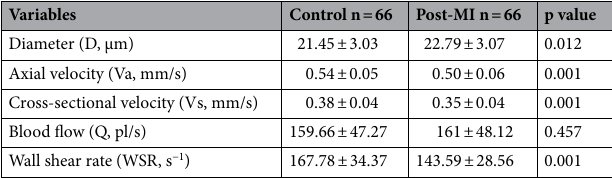
Table 2. Ocular microvascular parameters (mean ±